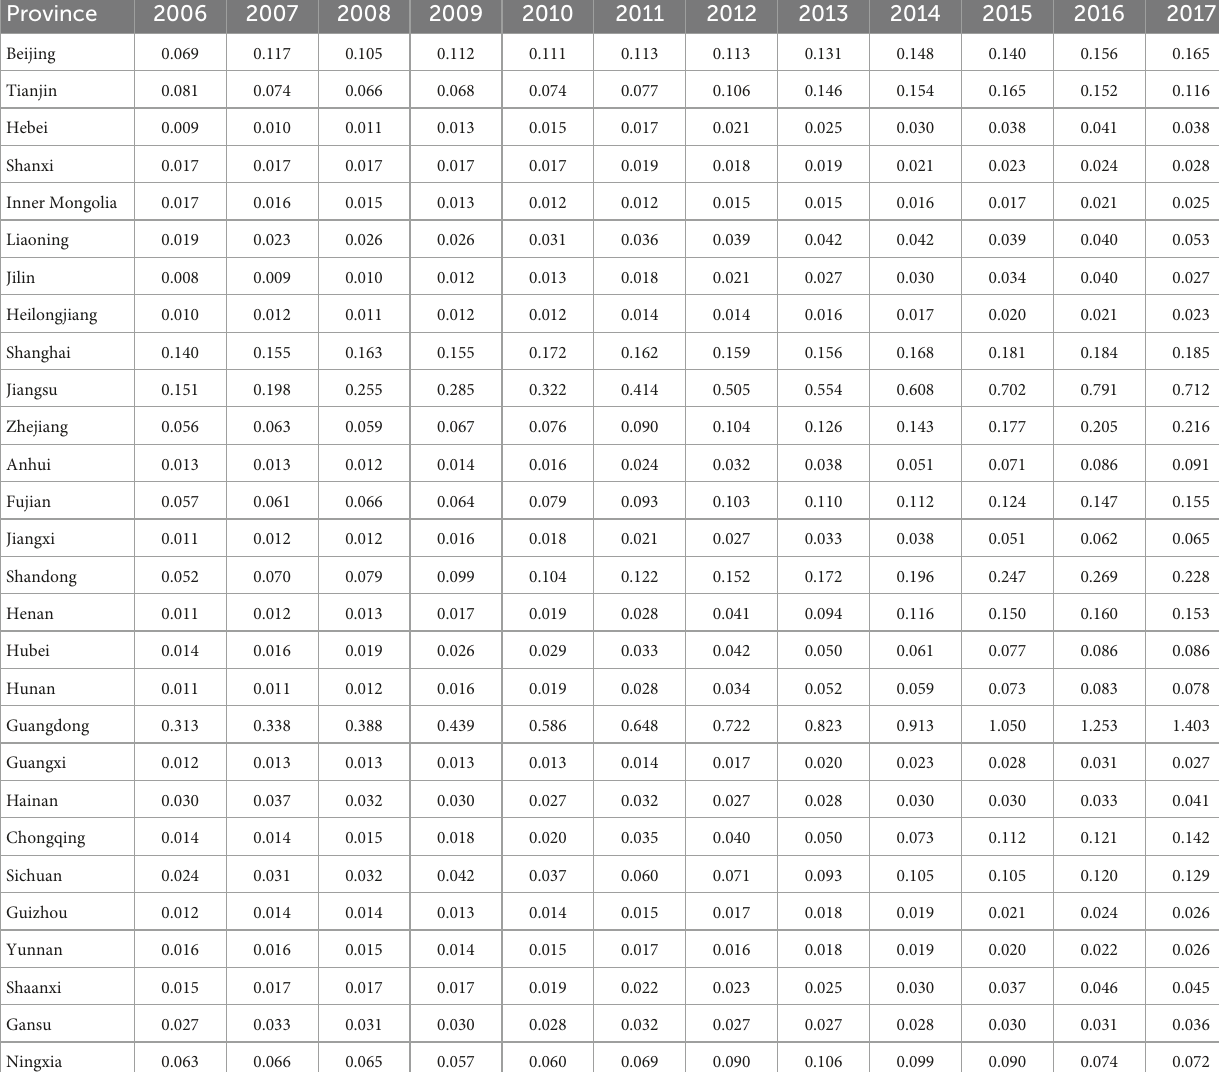
TABLE 4 Compositive output